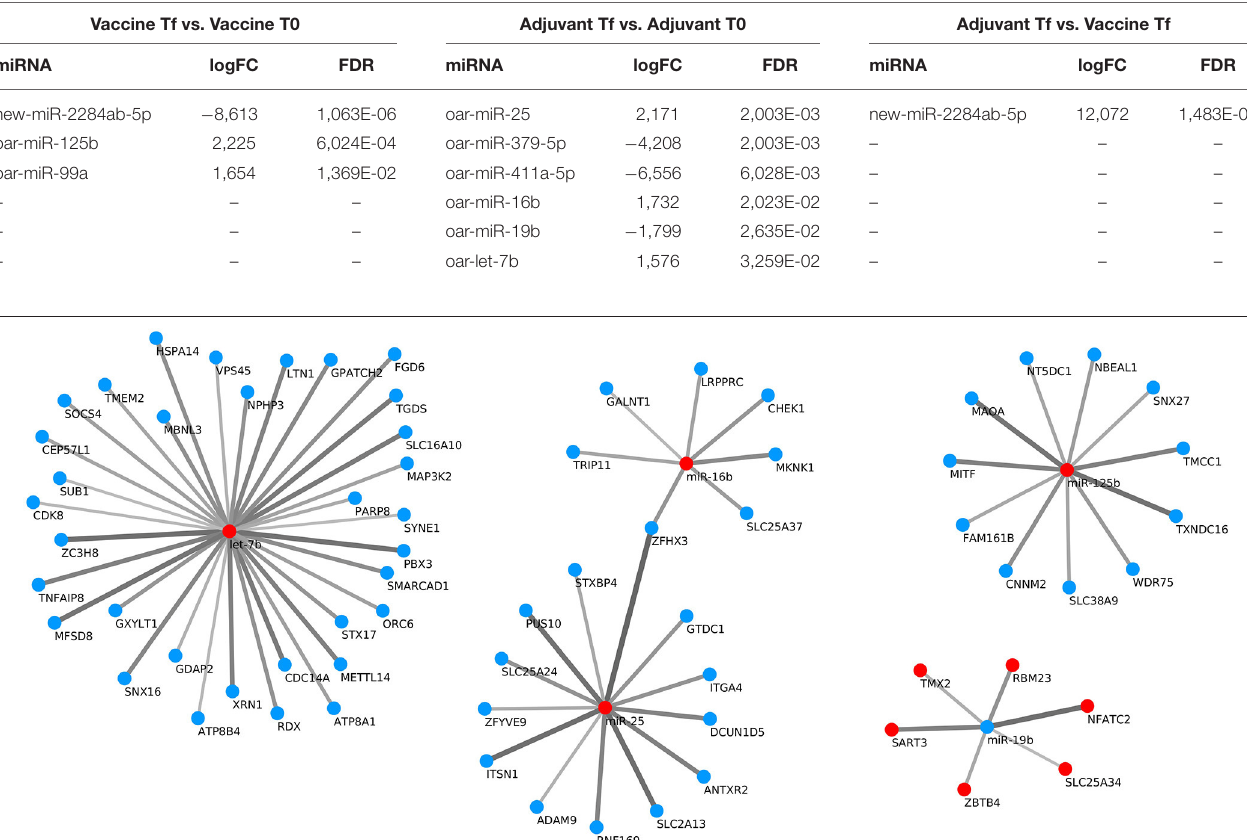
FIGURE 9 | Significant negative correlations (with an adjusted p -value < 0.05) between differentially expressed miRNA-target pairs. Red points represent up-regulation and blue ones down-regulation of the miRNA or target gene. The greater the absolute value of the Spearman’s rank correlation coefficient (rho), the broader and darker is the line joining the miRNA and predicted